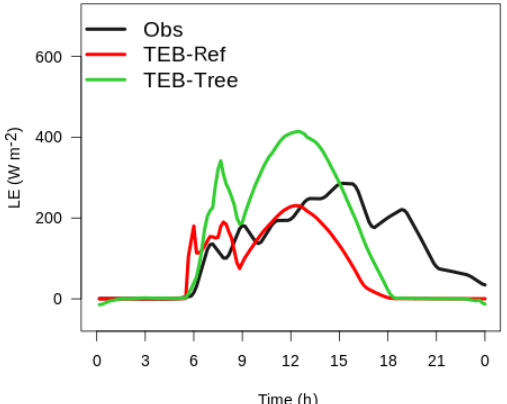
Figure 4. Comparison of the TEB-Ref and TEB-Tree results (red and green lines, respectively) with the latent heat flux deduced from measurements of tree transpiration and grass evaporation (black